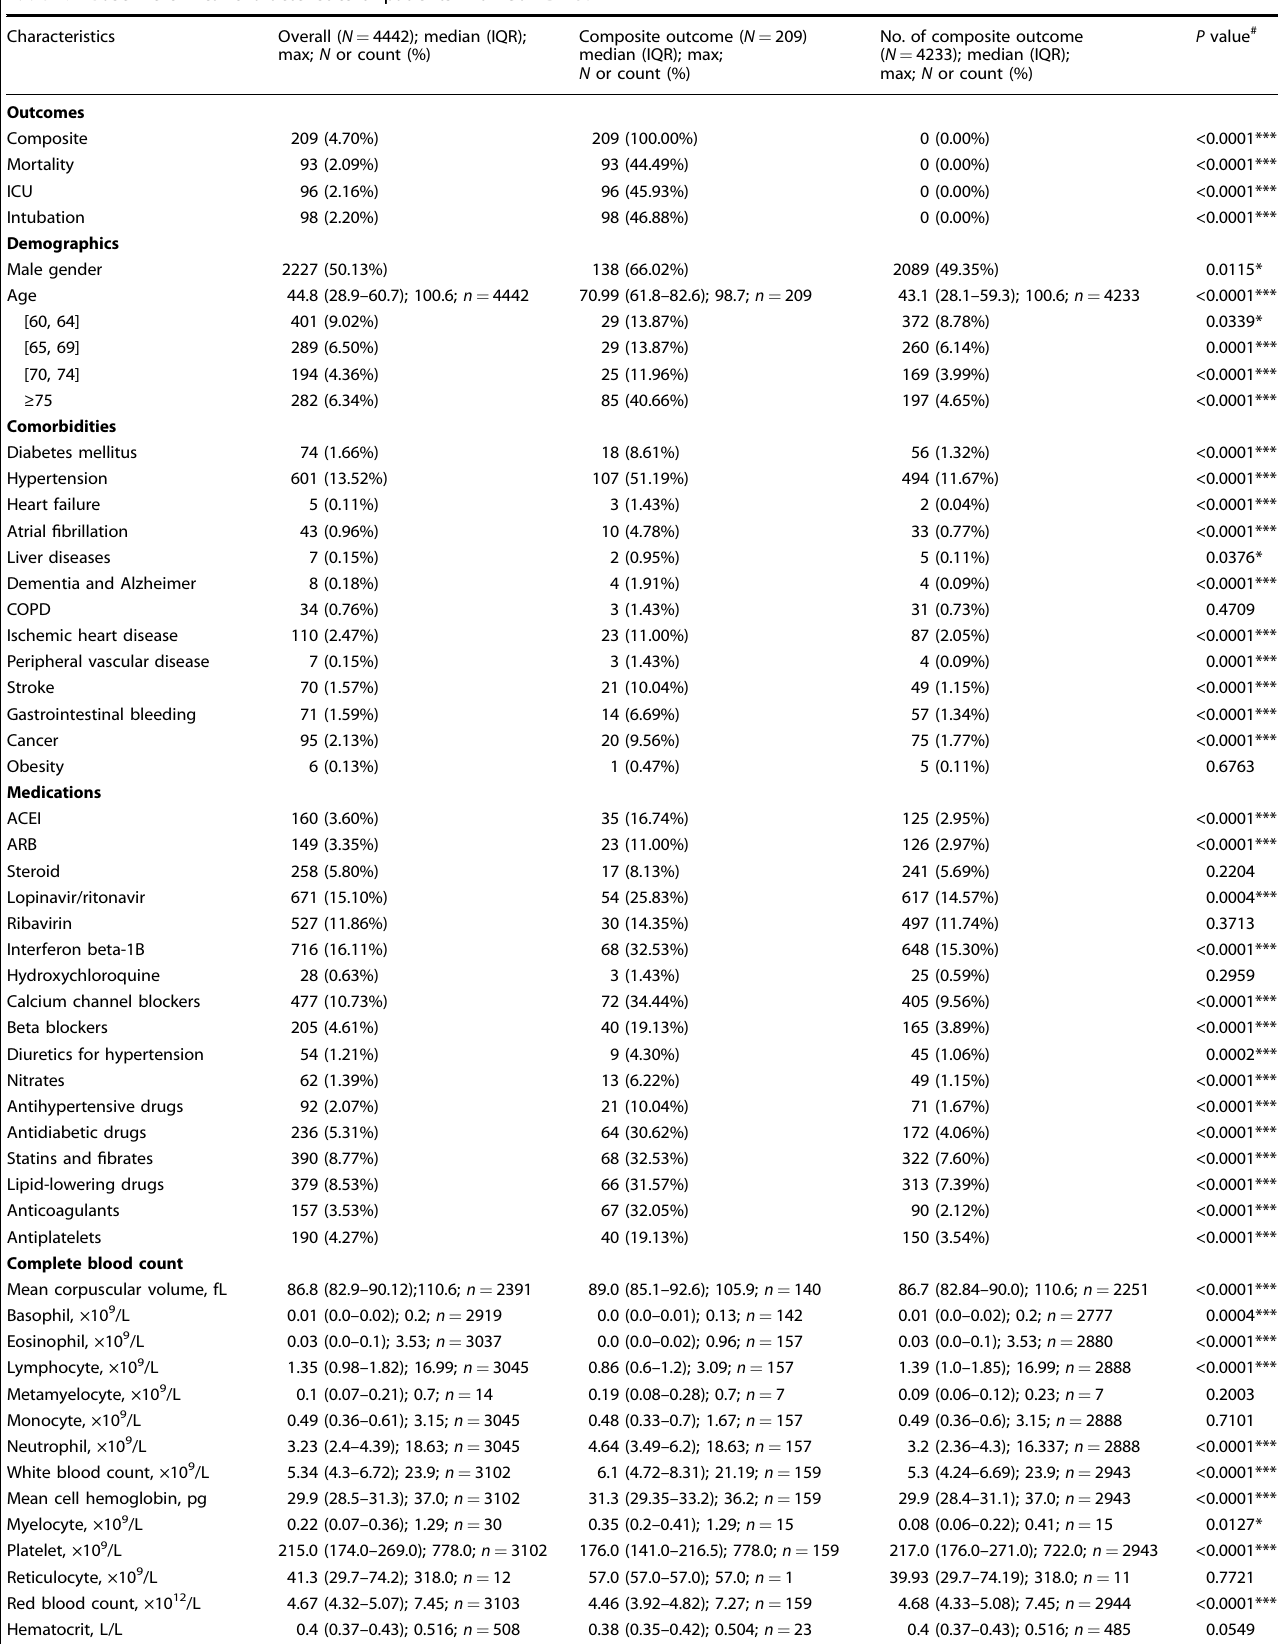
Table 1. Baseline clinical characteristics of patients with COVID-19.